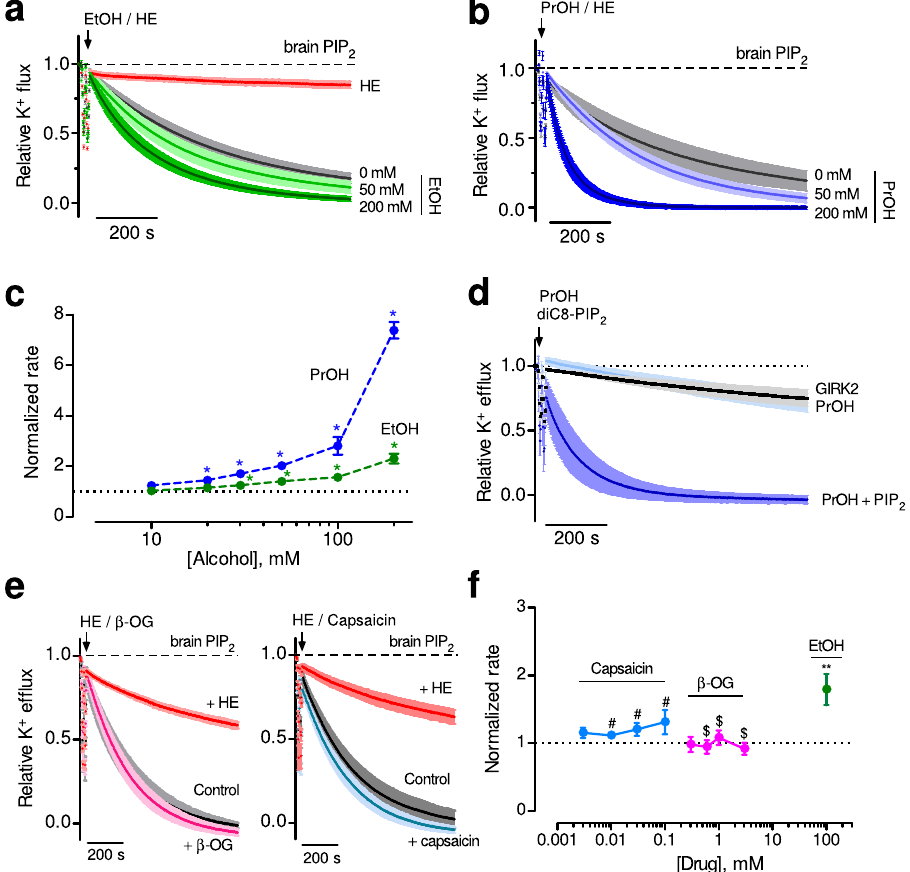
Figure 3. Alcohol directly activates GIRK2 channels in absence of G proteins. ( a,b ) Normalized fluorescent traces (mean ± SEM) show K + flux for GIRK2-containing liposomes with 1% brain PIP 2 and increasing concentrations of ethanol (EtOH) ( a ) (n = 12) (green traces) or propanol (PrOH) ( b ) (n = 4–6) (blue traces). (c) The normalized rate of K + flux is plotted as a function of ethanol (green) and propanol (blue) concentration. Inset, zoom of the dose-response curves over the physiological alcohol concentrations. * p < 0.05 vs. 10 mM using one-way ANOVA and Dunnett’s post hoc test (n = 5–6 for PrOH and 11–12 for EtOH). (d) Normalized fluorescent traces (mean ± SEM) show K + flux for GIRK2 in the presence of 100 mM PrOH in the absence (light blue, n = 3) or presence of 50 μ M diC8-PIP 2 (dark blue, n = 4). GIRK2 in the absence of both PrOH and diC 8 - PIP 2 is shown for comparison (black, n = 4). ( e) Normalized fluorescent traces (mean ± SEM) show K + flux for GIRK2-containing liposomes with 1% brain PIP 2 and 1 mM β -OG ( left ) (n = 4, magenta) or 30 μ M capsaicin ( right ) (n = 4, blue). MTS-HE inhibition is shown for comparison (red). (f) The normalized rate of K + flux is plotted as a function of different β -OG (pink) or capsaicin (blue) concentrations, and is compared to 100 mM EtOH (green). # not significant vs. 3 μ M Capsaicin, $ not significant vs. 0.3 mM β -OG, ** P < 0.05 vs. 3 μ M Capsaicin or 0.3 mM β -OG using one-way ANOVA and Dunnett’s post hoc